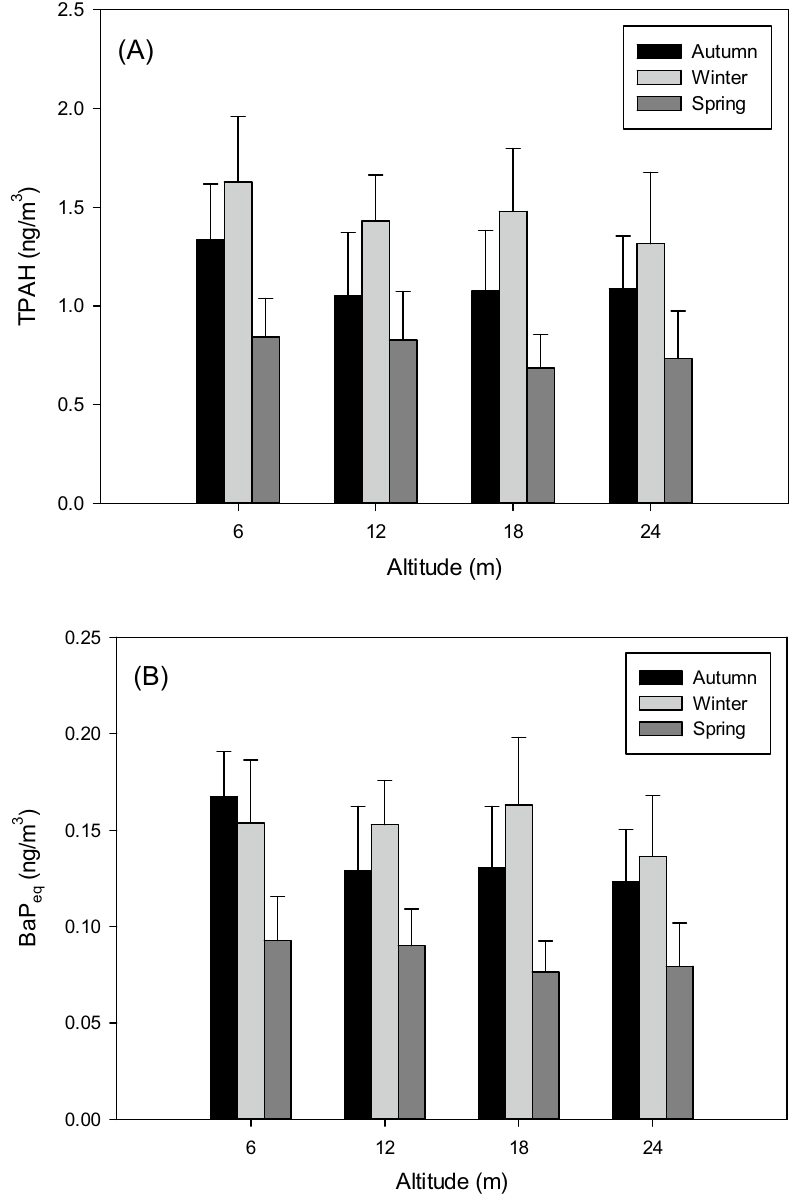
Figure 3. Concentrations of ( A ) PM 2.5 -associated PAH and ( B ) BaP eq in different